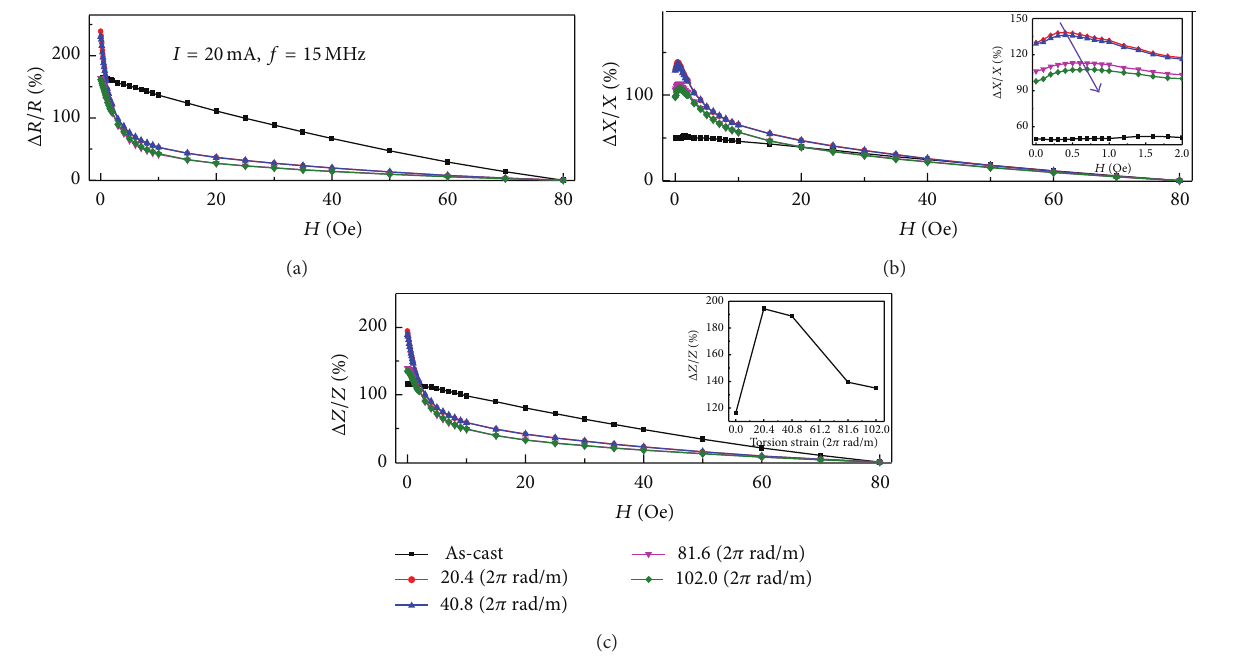
Figure 2: Magnetic field dependence of the magnetoresistance ( Δ𝑅/𝑅 ), magnetoreactance ( Δ𝑋/𝑋 ), and magnetoimpedance ( Δ𝑍/𝑍 ) ratios at 𝑓 = 15MHz for selectively applied torsion. And insets of the magnified peak positions of Δ𝑋/𝑋 in (b) and of the maximum values of Δ𝑍/𝑍 dependence to torsion strain in